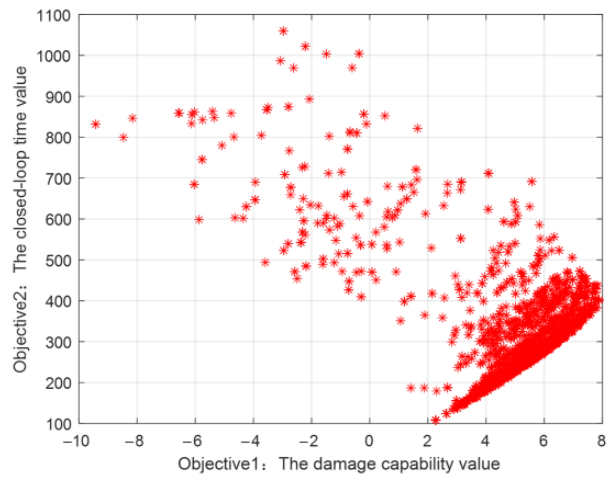
Figure 7. Solution